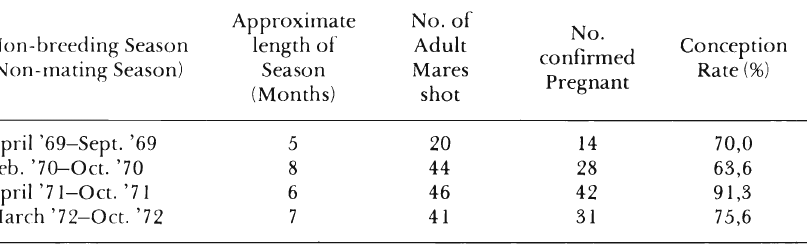
Comparison of non-breeding season conception rates for Burchell's zebra for each oj/our collJecutive yean. Only adult mares (3 to 20 years old) collected in the Central District oj the Kruger